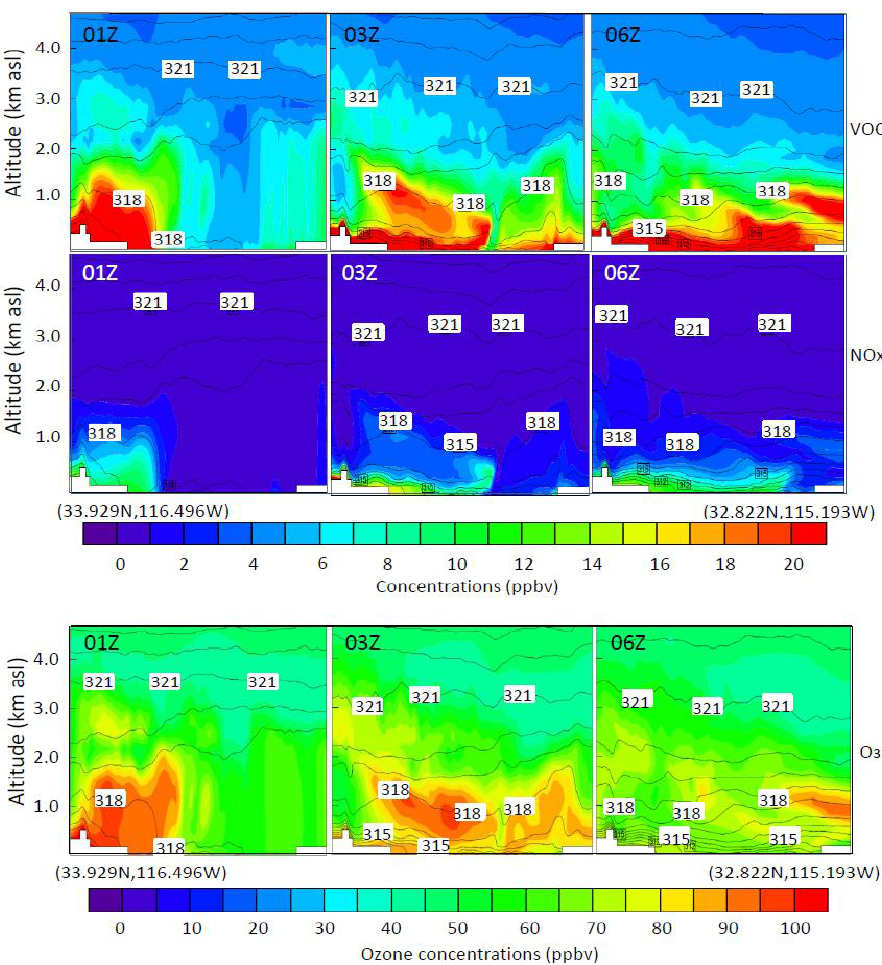
Figure 13. The vertical distribution of VOC (top), NO x (middle), and O 3 (bottom) along the cross-section D’D (shown in Fig. 1b) in the Salton Sea Basin at 01:00, 03:00, and 06:00UTC, 18 July 2005. Contours are potential temperature with 1K